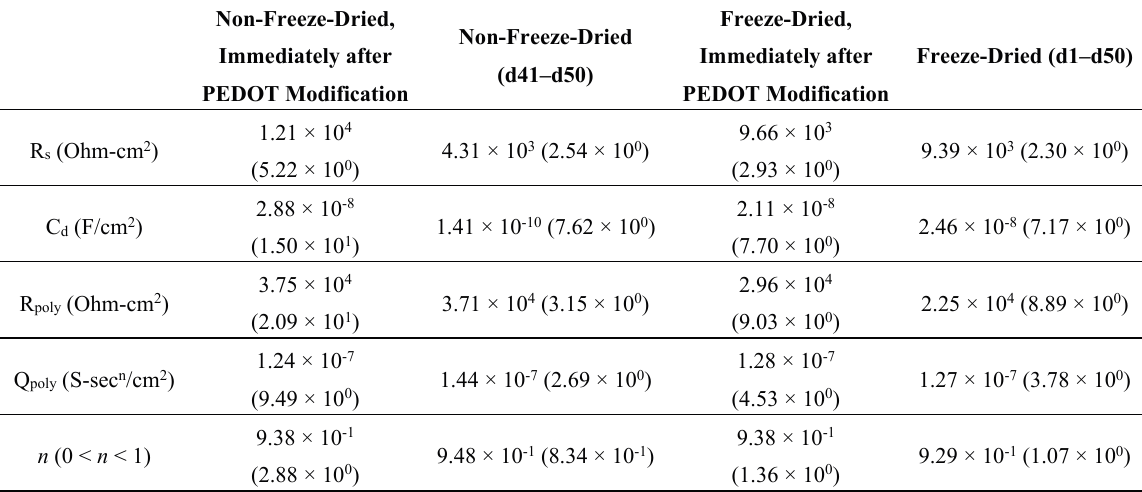
Table 1. Fit parameters for the EIS data from a non-freeze-dried microwire immediately after the PEDOT deposition and after failing during d41–d50. Values in the parentheses correspond to the rel. std. error (%). Parameters for a passed freeze-dried sample (d41–d50) are also added for comparison. n is the corresponding frequency power necessary for a better fit for non-ideal capacitors. Non-Freeze-Dried, Immediately after PEDOT